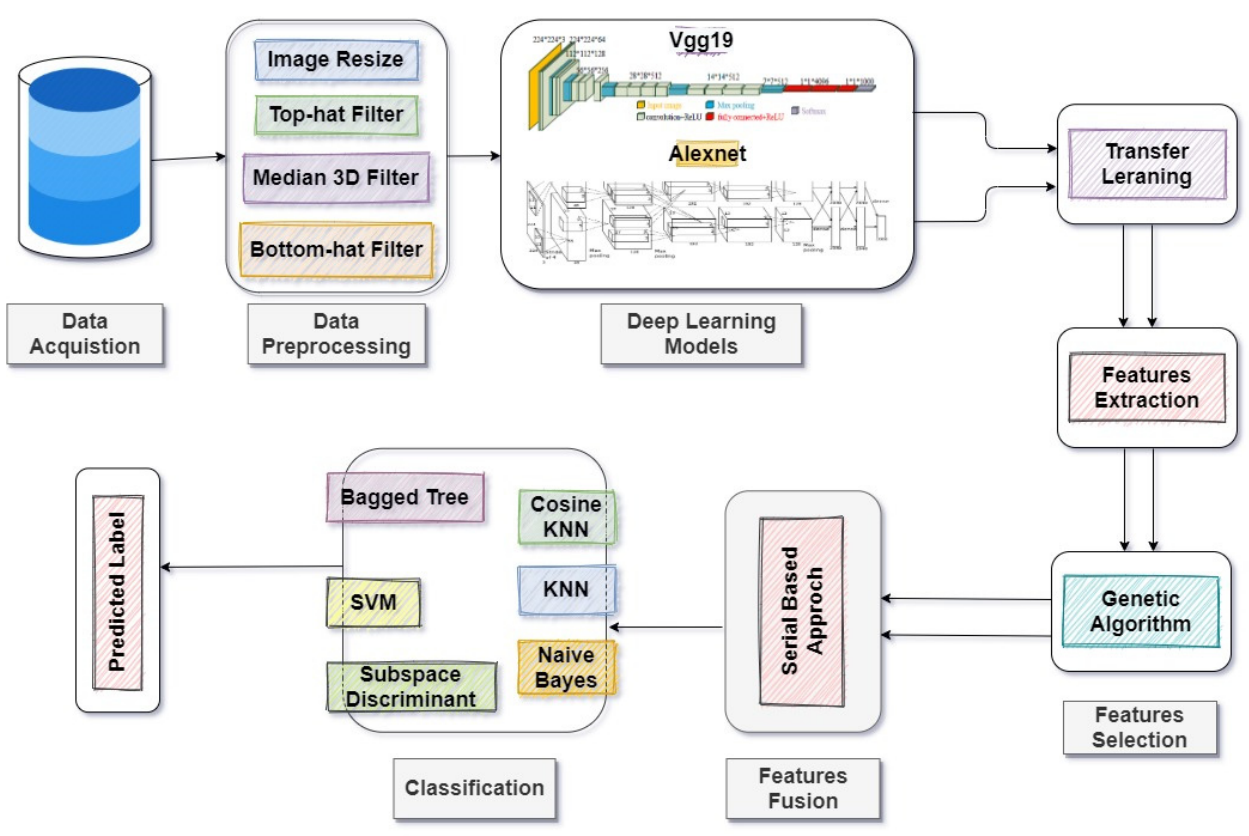
Figure 2. The proposed methodology for the detection and classification of stomach diseases.